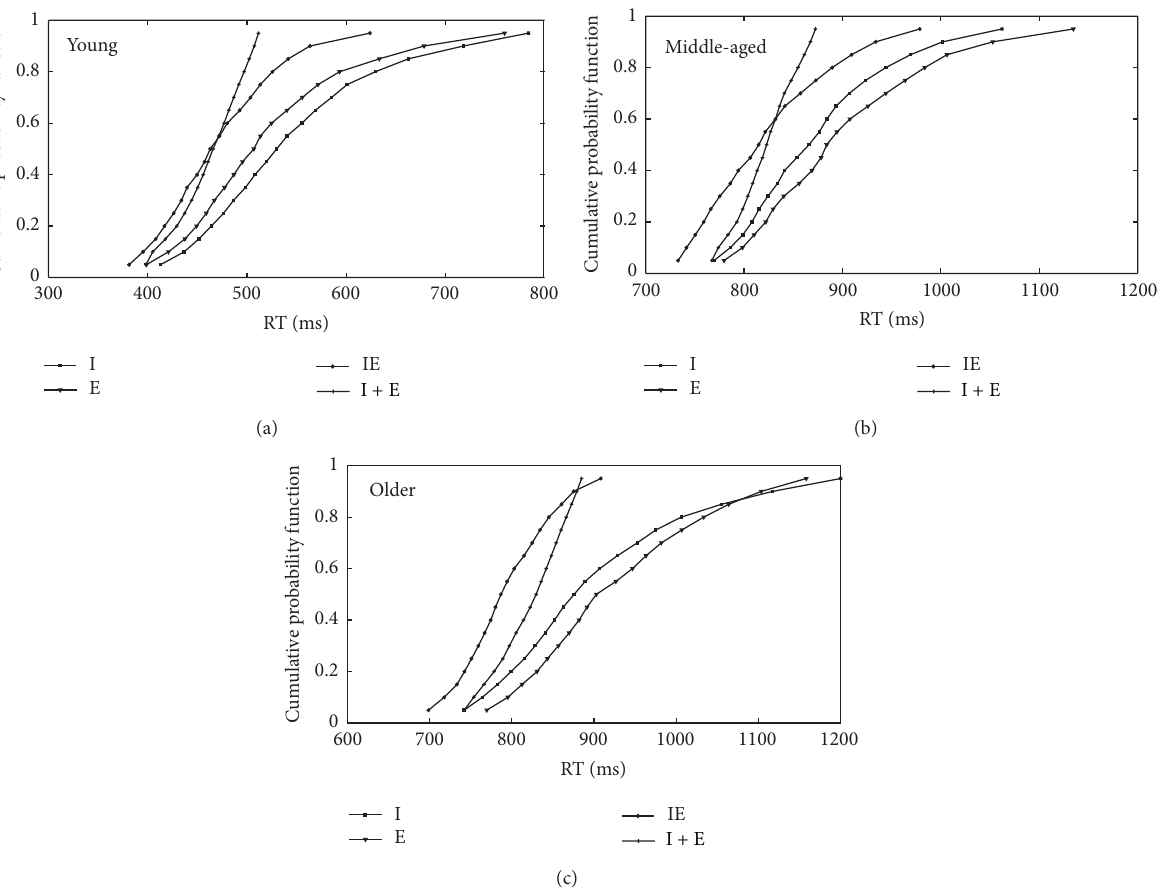
Figure 4: CDFs for redundant targets (IE), the sum of the distributions for emotional expression and identity targets (I + E), and single targets (E) and (I) in groups of young (a), middle-aged (b), and older (c)